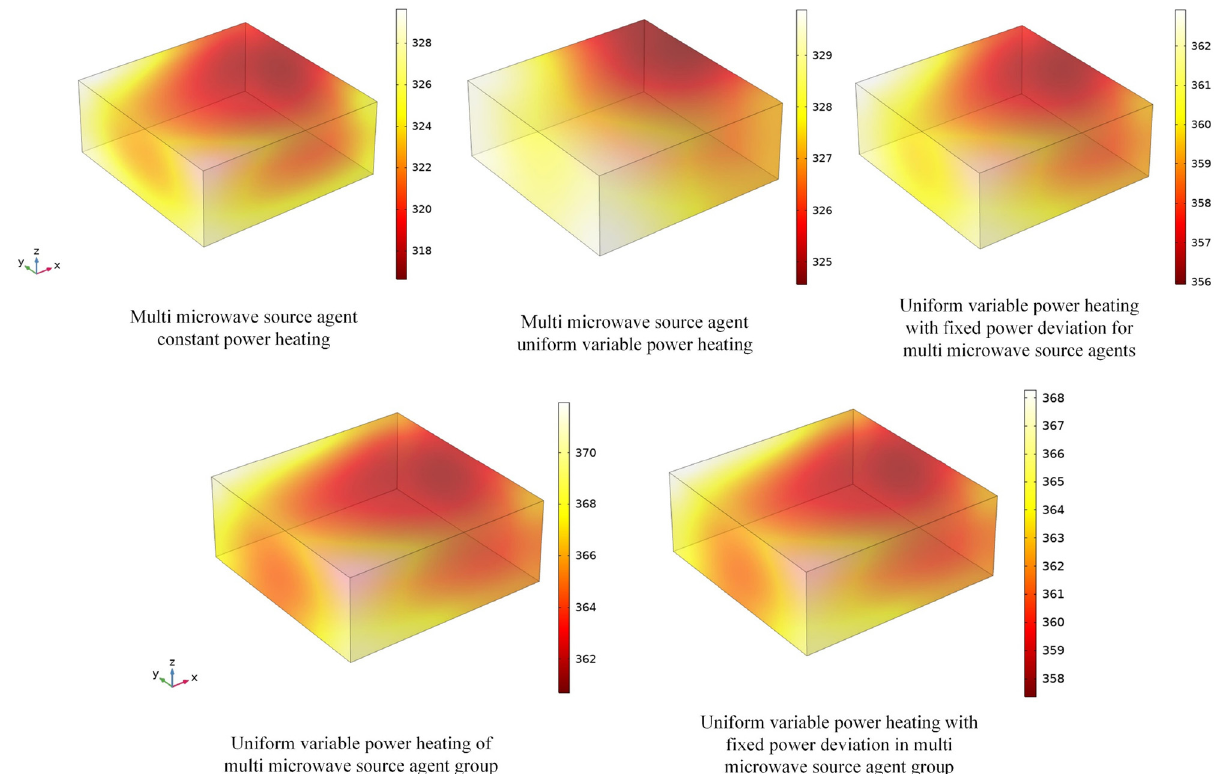
Figure 11: Comparison of the heating e ff ect.